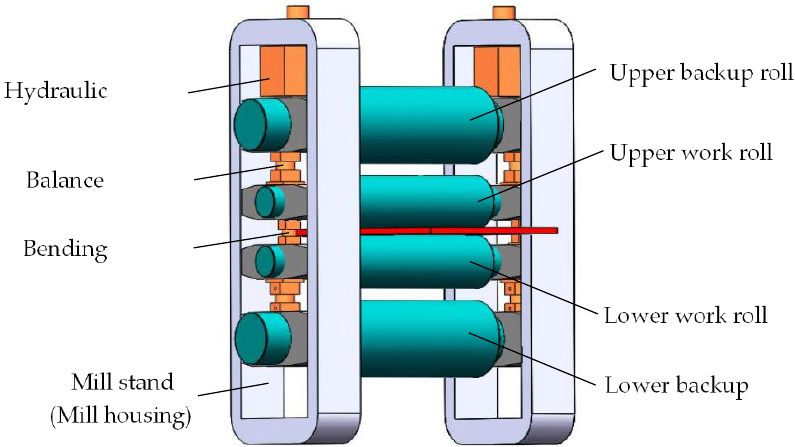
Figure 2. Structure diagram of a four-high hot rolling mill.